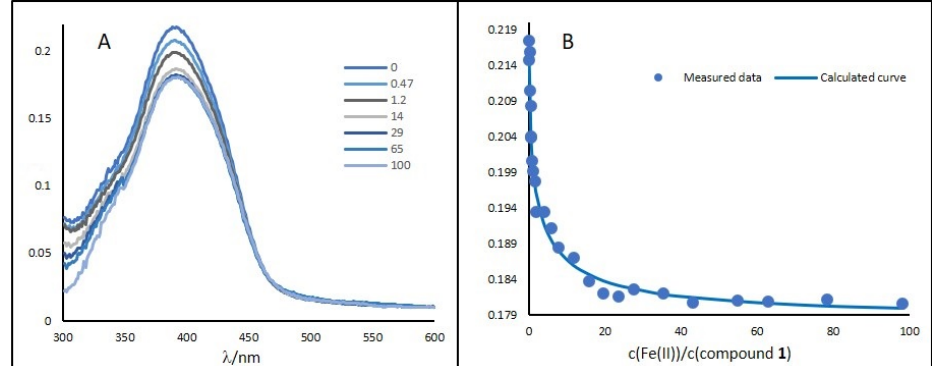
Figure 3. ( A ) UV–VIS spectra of compound 1 and its change in the presence of Fe(II) ions. ( B ) Titration curves for compound 1 (10 μ M) showing the dependence of the complex absorbance at excitation maximum on the Fe(II) concentration (0–5 mM) in aqueous medium (water/DMSO, 99:1, v / v ).